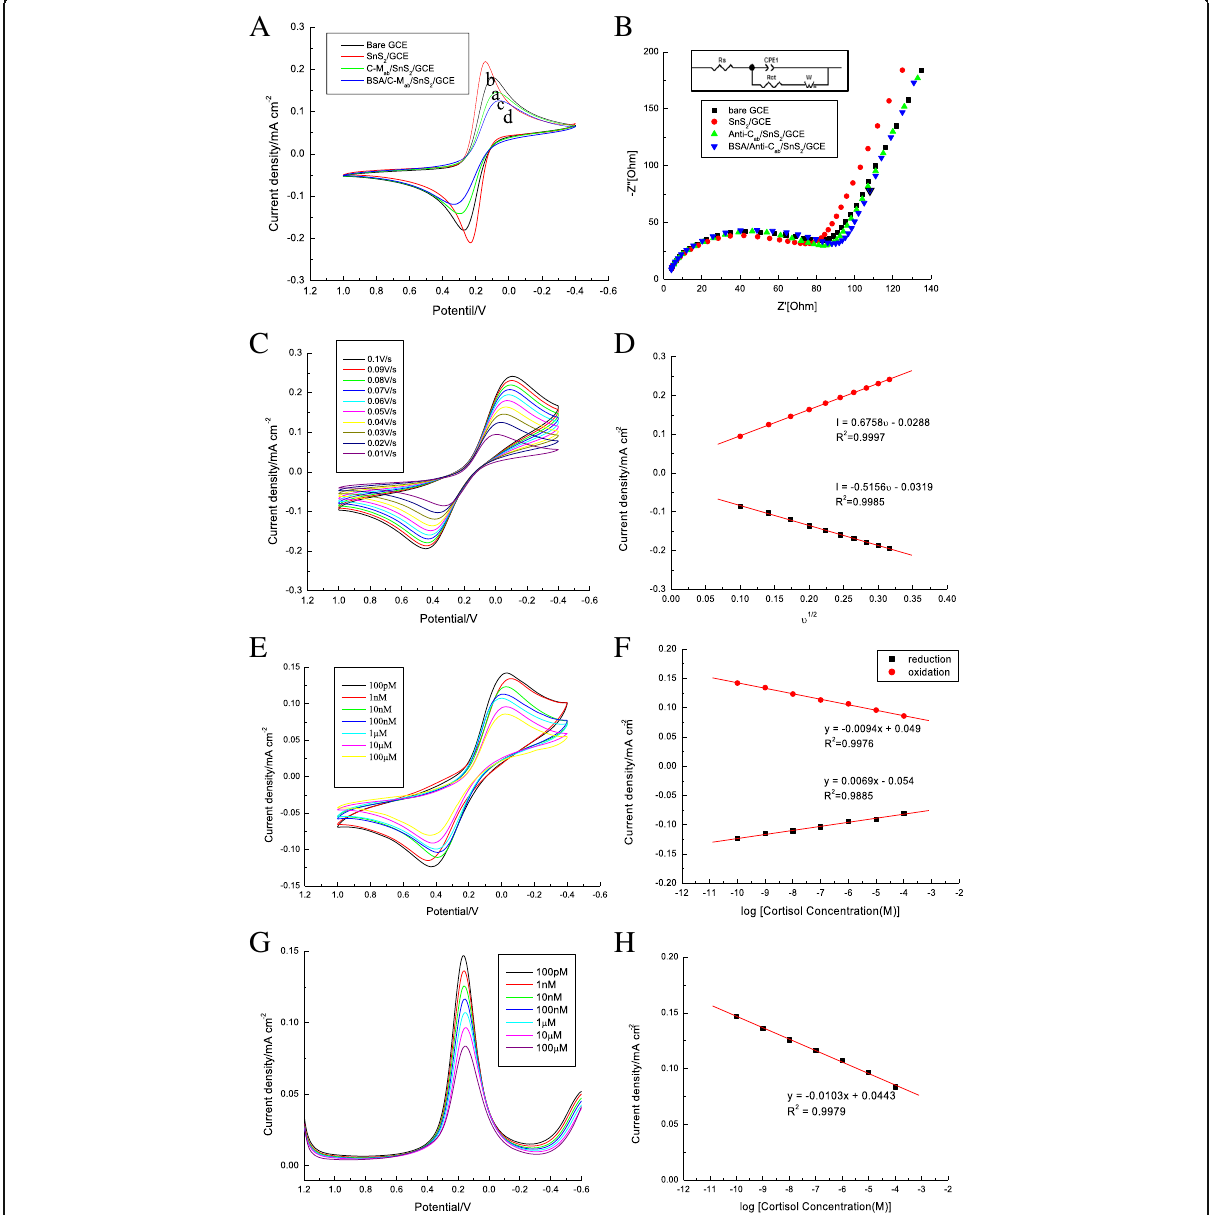
Fig. 3 a CV response study of GCE electrode (curve a), SnS 2 /GCE electrode (curve b), C-M ab /SnS 2 /GCE electrode (curve c), BSA/C-M ab /SnS 2 /GCE electrode (curve d). b EIS response study of the GCE, SnS 2 /GCE, C-M ab /SnS 2 /GCE, and BSA/C-M ab /SnS 2 /GCE electrodes. Inset: the corresponding equivalent circuit. c Increased magnitude of oxidation response current of BSA/C-M ab /SnS 2 /GCE electrode with increased scan rate from 10 mV/s to 100 mV/s. d The current magnitude increased with increasing scan rate. e CV studies of BSA/C-M ab /SnS 2 /GCE electrode as a function of cortisol concentration varying from 100 pM to 100 μ M. f Linearity curve for the current response with different cortisol concentrations. g DPV studies of BSA/C-M ab /SnS 2 /GCE electrode as a function of cortisol concentration varying from 100 pM to 100 μ M. h Linearity curve for the current response with different cortisol